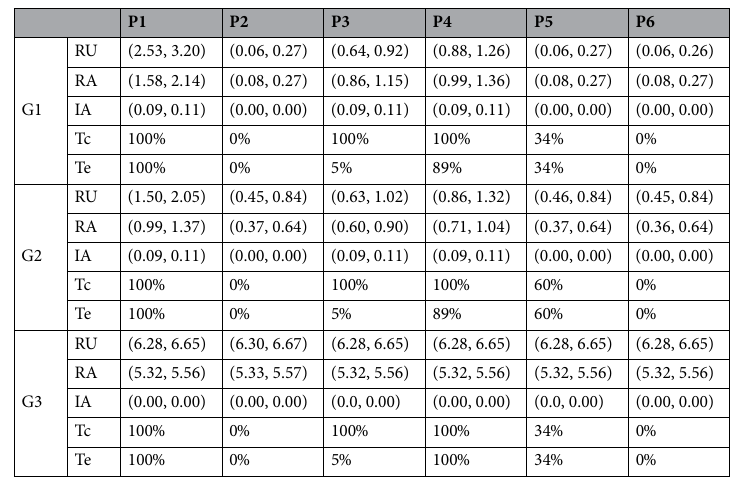
Table 1. Results for effectiveness of travel regulation policies P1 through P6 for synthetic data. Shown are 2.5th and 97.5th percentiles of travel and health outcomes for the policies using estimated epidemiological parameters to simulate epidemic and travel data. G1, G2, and G3 denote countries in Group 1, 2, and 3, respectively. The relative change in the number of cases (including detected and undetected), RU, is the difference at the end and at the beginning of the regulated period divided by the number of cases at the beginning of the period; The relative change in the number of confirmed cases, RA, is the difference in the number of confirmed cases at the end and at the beginning of the regulated period divided by the number of confirmed cases at the beginning of the period; IA is the percentage of incoming travelers who will eventually move to the active confirmed category after arrival; Tc is the percentage of inbound travel capacity; and Te is the percentage of expected of inbound